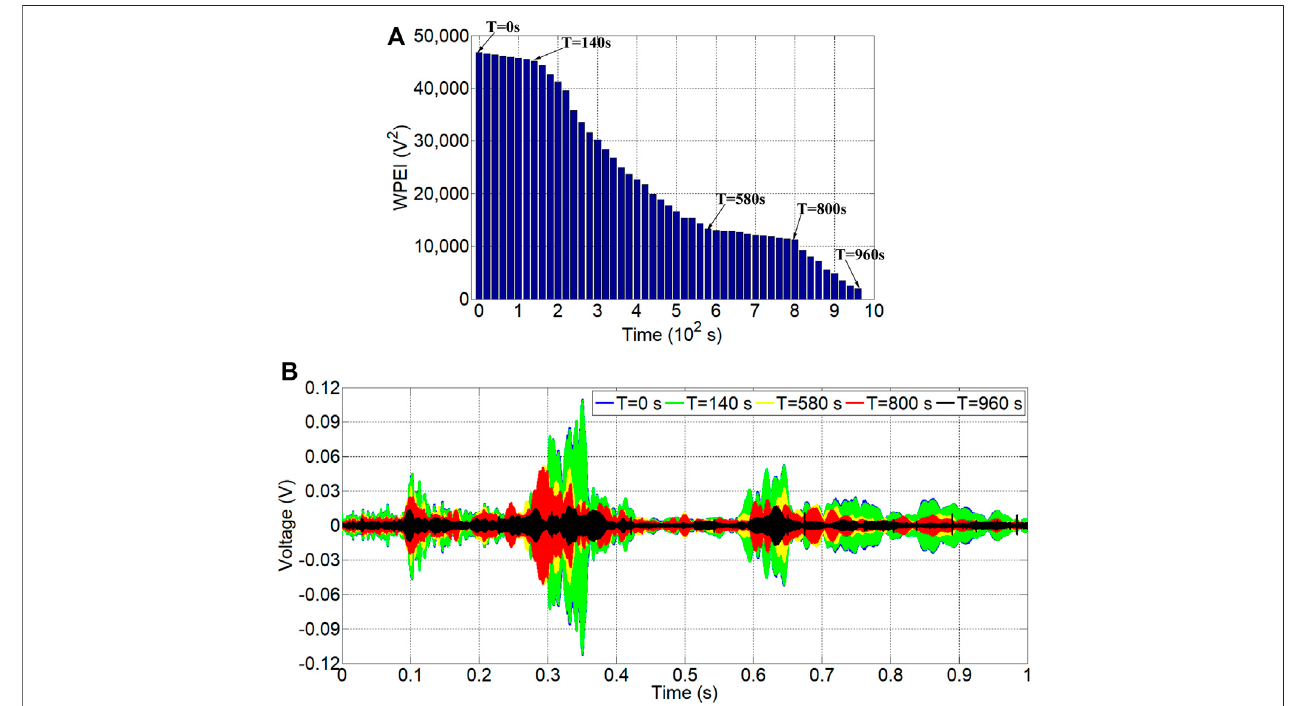
FIGURE 8 | WPEIs and received signal of S1: (A) WPEIs of the received signal; (B) the received stress wave signal.